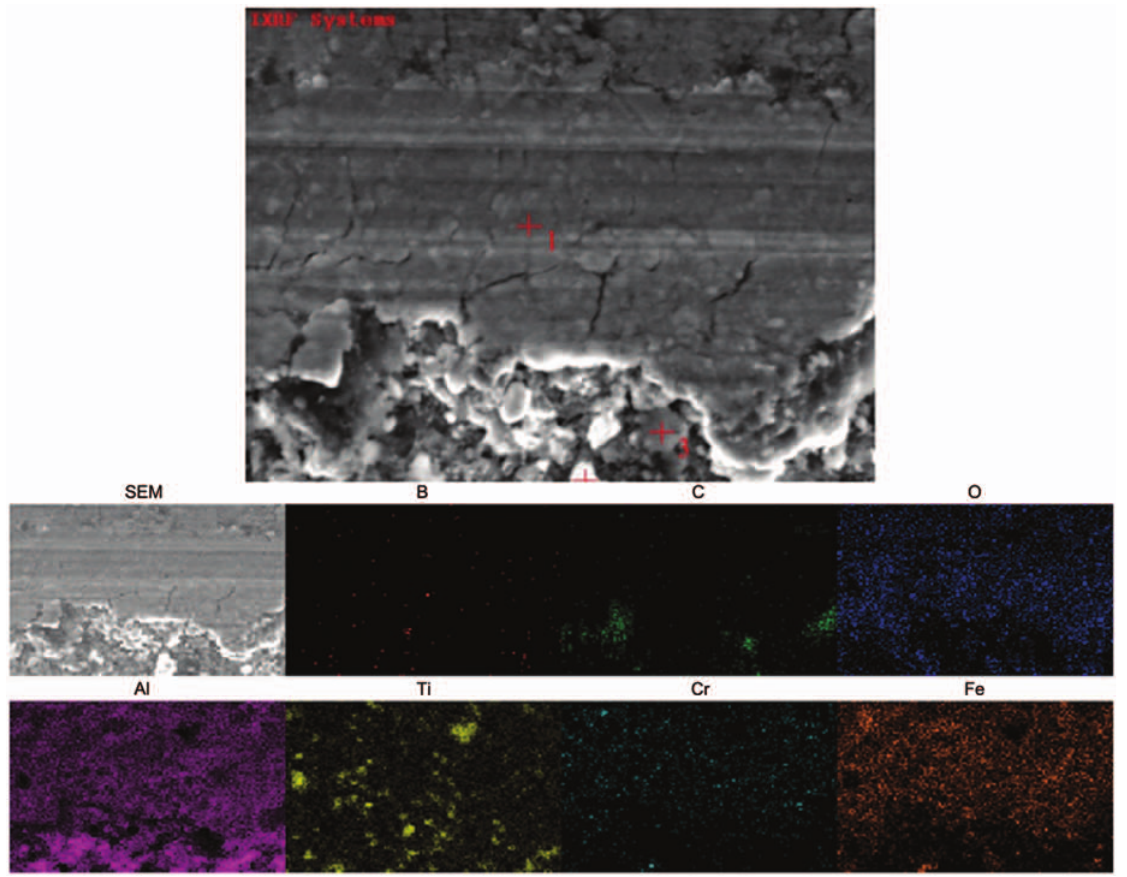
Figure 8 EDS analysis of worn 20 % TiB